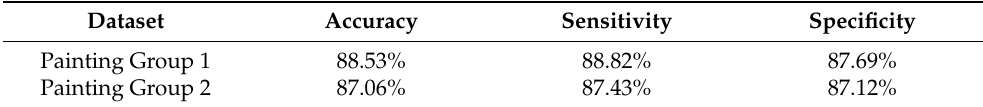
Table A9. Logistic regression scores for the two grouped painting datasets.